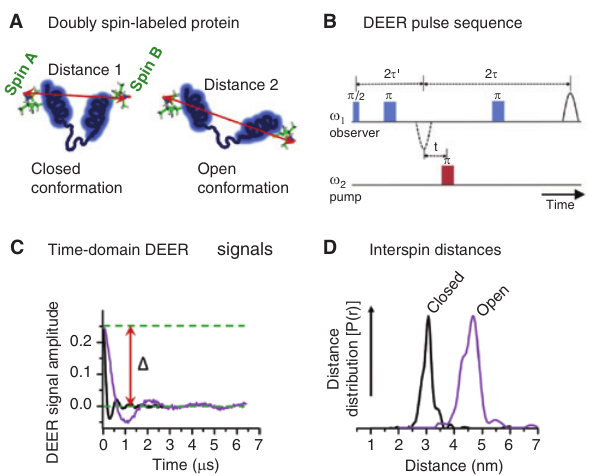
Figure 5: Distance measurements based on the four-pulse DEER experiment. (A) DEER measures distances between pairs of spin labels in protein molecules and complexes. Two conformations of a doubly spin-labeled protein are shown. In frozen solutions the nitroxide spin labels (and the magnetic tensors of their electron spins) have different orientations relative to the external mag- netic field, hence leading to broad EPR spectra due to magnetic tensors anisotropy. Consequently, two groups of similarly oriented nitroxides, referred to as “Spins A” and “Spins B” corresponding to different parts of the EPR spectrum can be selected and their dipole-dipole interaction determined by using for example a DEER pulse sequence in order to produce the interspin distance. (B)